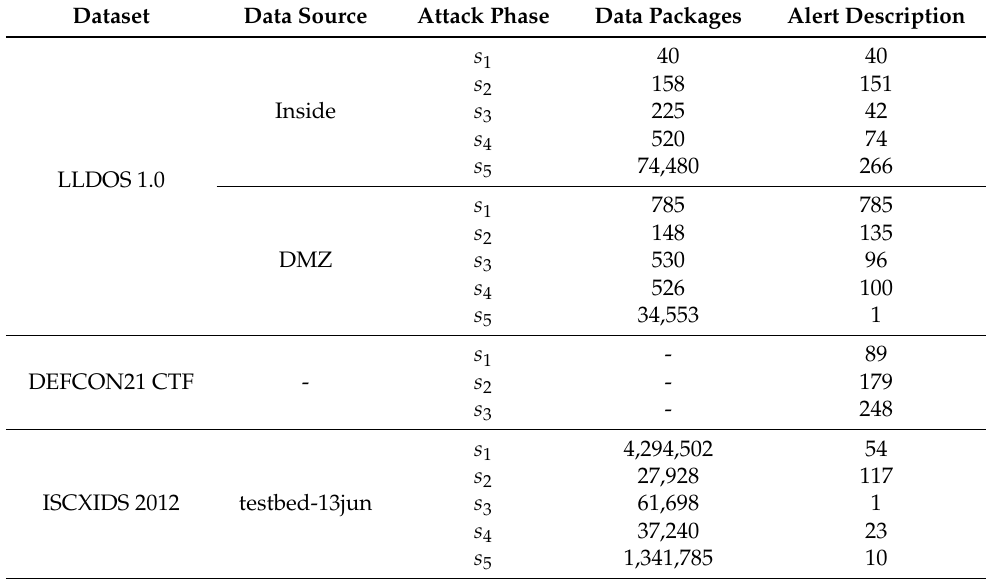
Table 1. The datasets of the multi-step attack sequence.